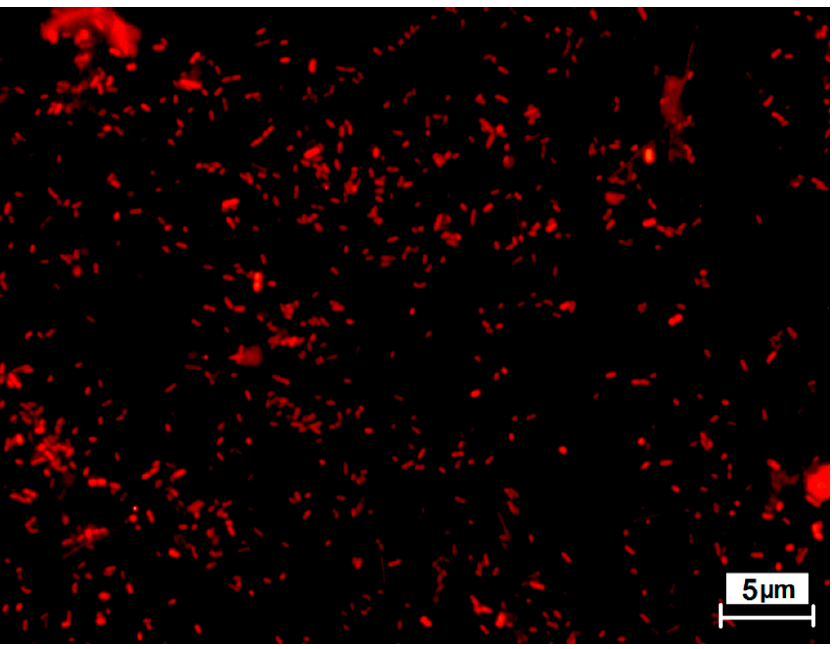
Figure 9. Specific identification of whole fixed bacterial cells with fluorescent oligonucleotide probes (FISH) in the WAF + SS + Lignin sample.